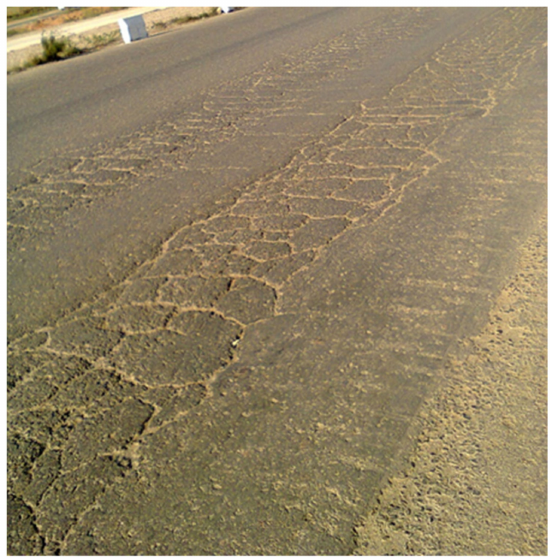
Figure 3. Example of rutting in flexible